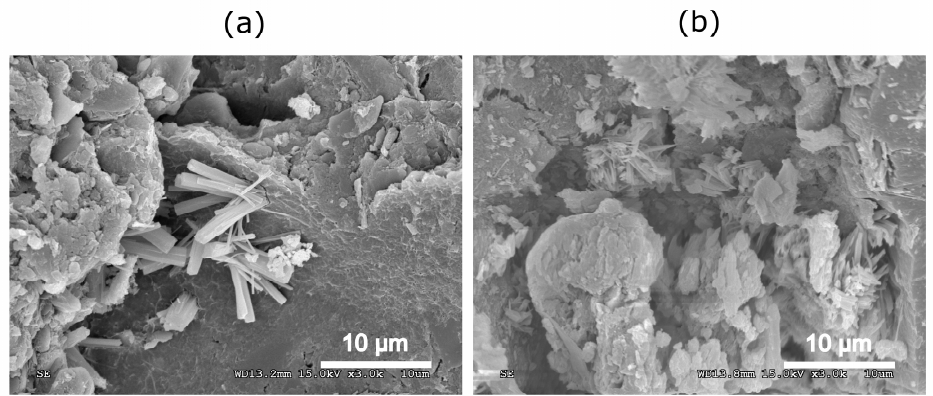
Figure 11. SEM images of ettringite crystals at 6 months in ( a ) cement samples without the industrial waste and with the sulfate solution and ( b ) lime samples with the waste and sulfate solution.